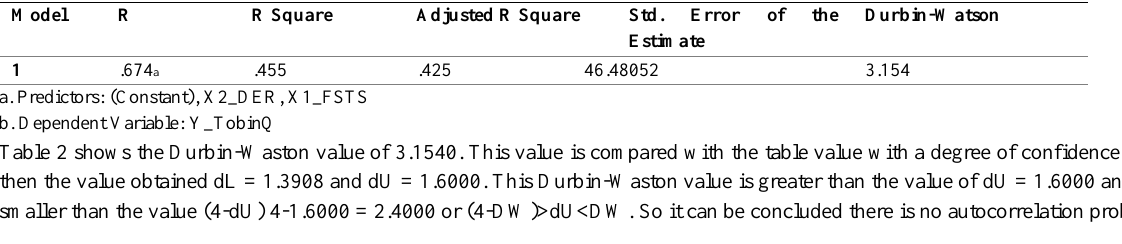
Table 3: Development of Foreign Sales to Total Sales (Export)